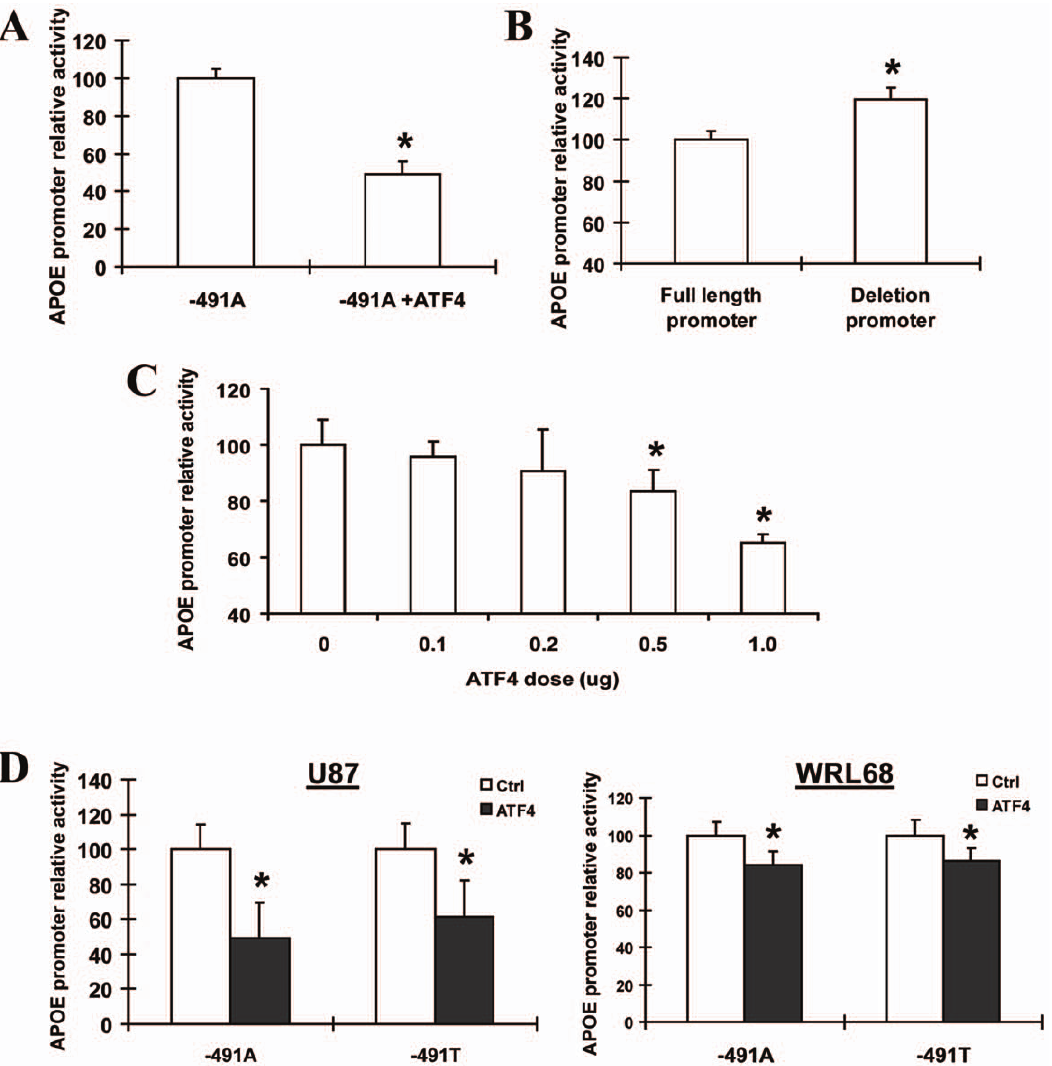
Figure 3. ATF4 regulates cloned APOE promoter activity. (A) The pcDNA3.1-ATF4 or pcDNA3.1 control vector was transfected into U-87 cells together with APOE promoter luciferase reporters and internal control plasmid Renilla, the APOE promoter activity was examined by dual-luciferase assay. (B) APOE promoter reporter (with 2 491A) or the deletion of the putative ATF4 binding sequence ( 2 487 to 2 469) of cloned APOE promoter ( 2 1017 to + 406 with 2 491A) was transfected into U-87 cells, luciferase assay was then performed to determine the activity of the promoter. (C) A series of 0.1 ug to 1.0 ug of ATF4 plasmids were transfected into WRL-68 cells together with APOE promoter reporters to determine the dose- dependent effect of ATF4 on regulating APOE promoter activity. (D) ATF4 over-expression significantly down-regulated the activities of cloned APOE promoters both with 2 491A and 2 491T allelic forms in U-87 and WRL-68 cell lines by dual-luciferase assay. The Y-axes represent the percent activity of the APOE promoter relative to the control condition (set at 100%). All data were collected from three independent experiments in triplicate set up, * p , 0.05.